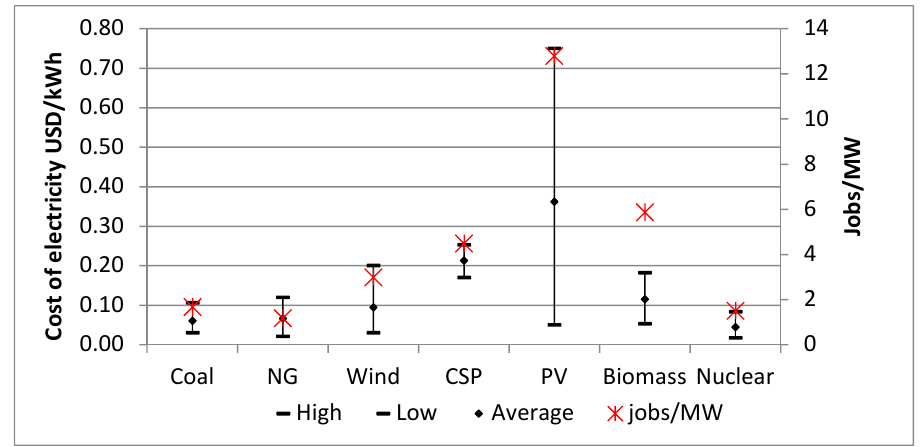
Figure 4. Electricity generation costs and job creation of the assessed technologies [15,41–43,45,46,48,59].